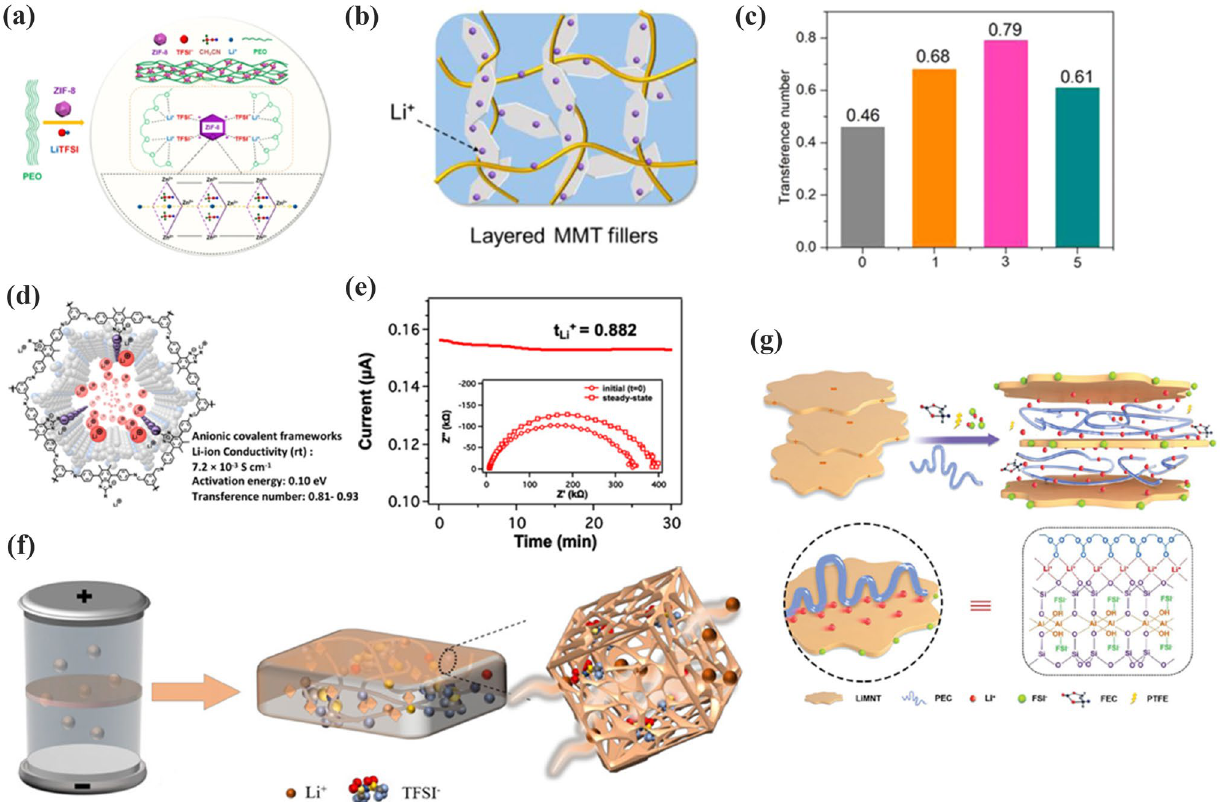
Fig. 11 a Lithium-ion conductive mechanism of ZIF-8-PEO CPEs. Adapted with permission from Ref. [79]. b Transport pathway of lith- ium-ion in BNN-CPEs; c transference number of different content of BNN. Adapted with permission from Ref. [140]. d Li-ion transfer in Li- ImCOFs; e t Li+ of LiImCOF-PEO CPEs. Adapted with permission from Ref. [141]. f Mechanism of ion transport in Fe-MOFs-PEO CPEs. Adapted with permission from Ref. [142]. g Intercalation LiMNT-PEC CPEs with enhanced t Li+ mechanism. Adapted with permission from Ref.